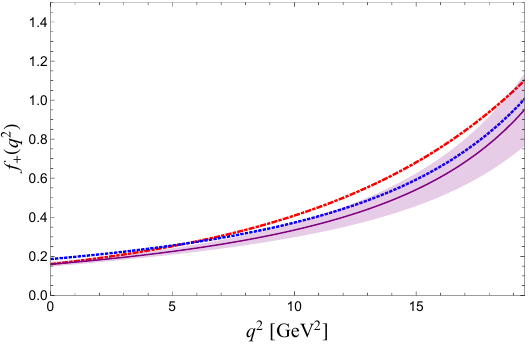
Figure 4 . The purple solid line and the area represents our result for f + ( q 2 ) form factor with errors; the blue dashed-line is the result of CCQM [51] and the red dash-dotted one is the LFQM prediction from